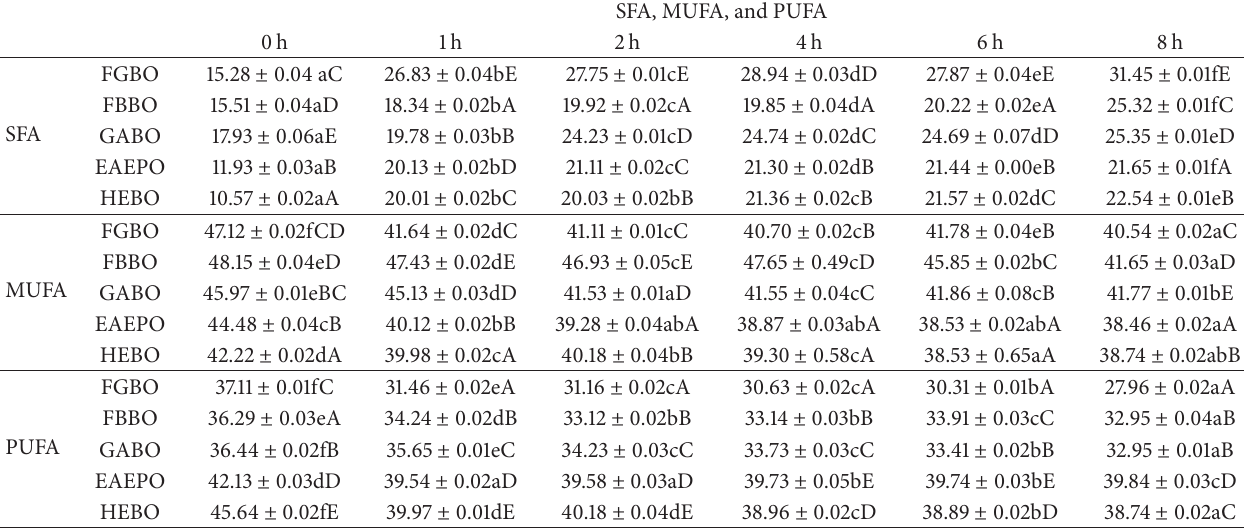
Table 4: Changes in saturated, monounsaturated, and polyunsaturated fatty